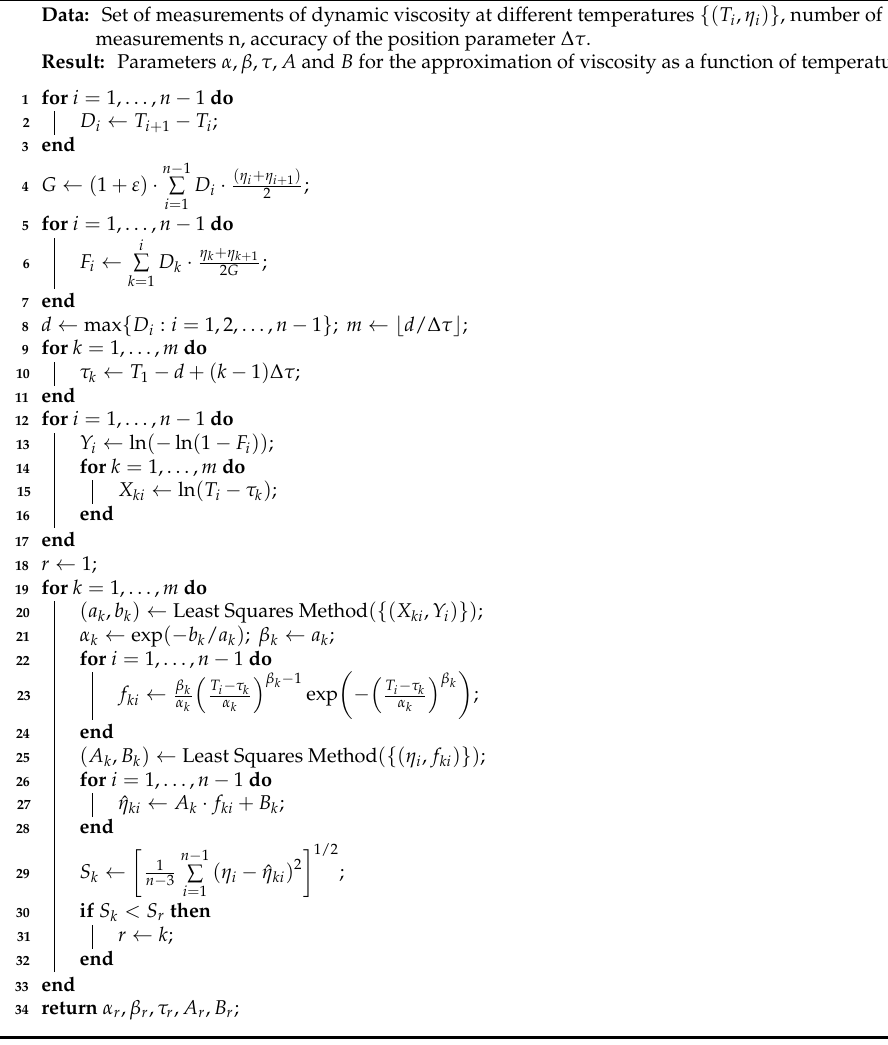
Algorithm 1: Procedure of determining the parameters of the viscosity approximation for one